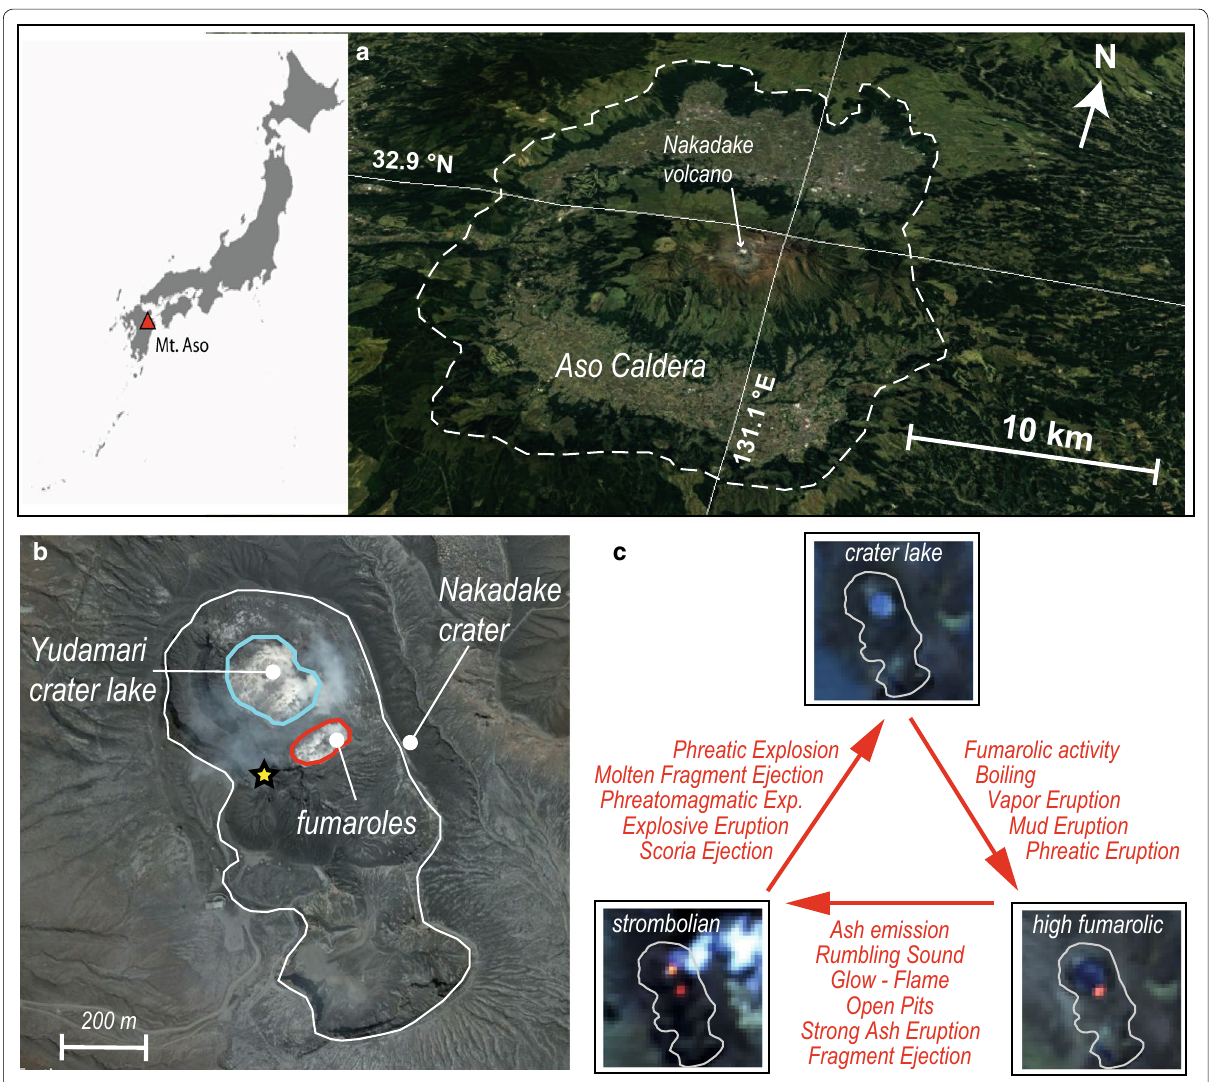
Fig. 1 a Aso caldera and Nakadake volcano in north-central Kyushu. b Google Earth snapshot of Nakadake crater; the star represents the site from where ground-based measurements were collected. The Yudamari crater lake and the fumarole field are also shown by cyan and red contours, respectively. c Schematic diagram of the cyclic volcanic processes at Nakadake crater (modified after Sudo 2001). The three representative Landsat- class images (false color RGB; R : 2.2 µm; G : 1.6 µm; B : 0.8 µm) at the vertexes of the triangle illustrate the thermal pattern during the principal phases of activity (crater